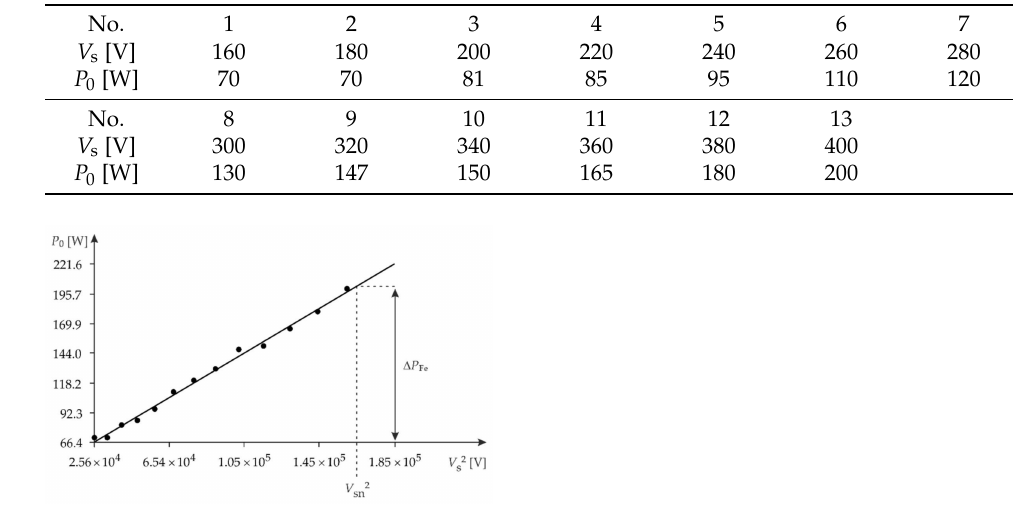
Table 1. Measured results for the magnetisation characteristic in the idle state.